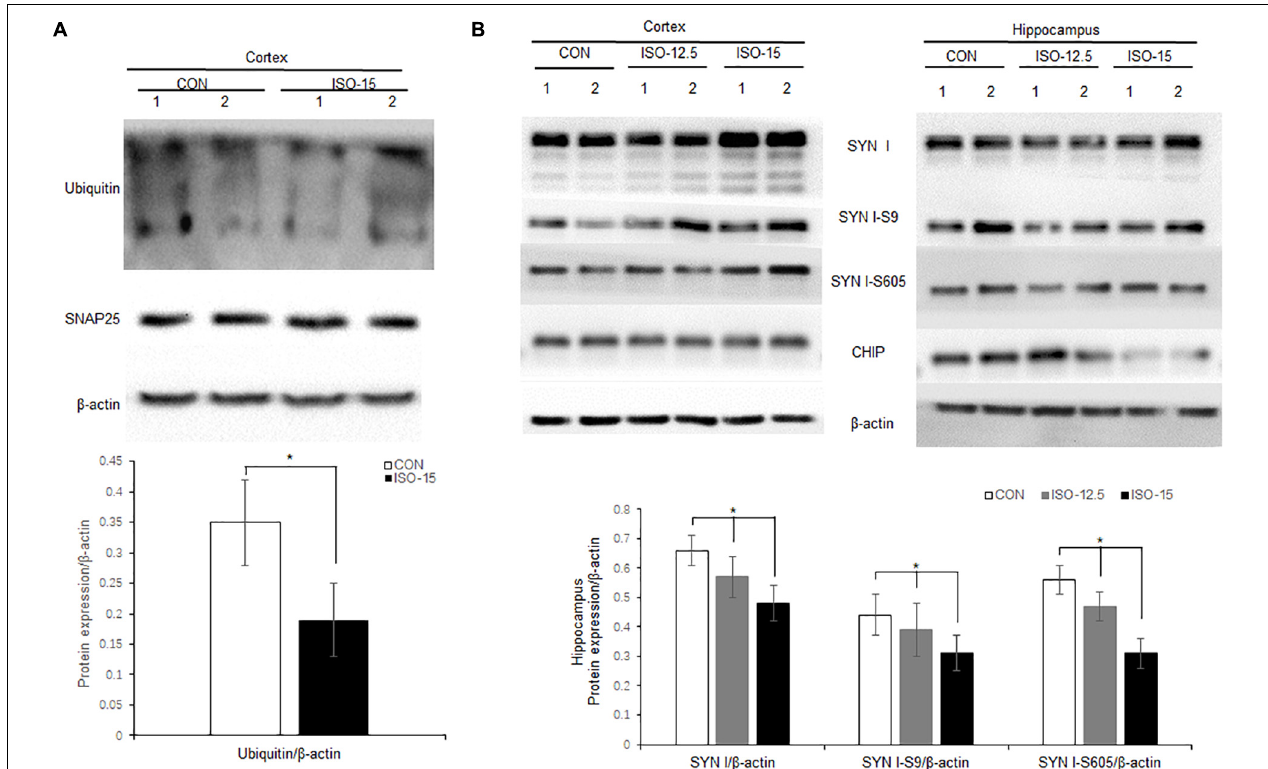
FIGURE 5 | Ubiquitin and synaptic protein expression changed in isoflurane-exposed aged mice. (A) Ubiquitin expression was decreased in the cortex brain tissue in the ISO-15 group, while there was no significant difference in synaptic protein SNAP25 expression in the cortex ( n = 6, * p < 0.05). (B) In the brain tissue of cortex, there was no significant difference in the expression level of synapsin I and the phosphorylation level of synapsin I S9 and S605 between CON group, ISO-12.5 group, and ISO-15 group. In the brain tissue of the hippocampus, the expression level of synapsin I and the phosphorylation level of synapsin I S9 and S605 were decreased in both the ISO-12.5 group and ISO-15 group, compared with the CON group, and the expression level of CHIP had a dramatic decline in the ISO-15 group ( n = 6, * p <